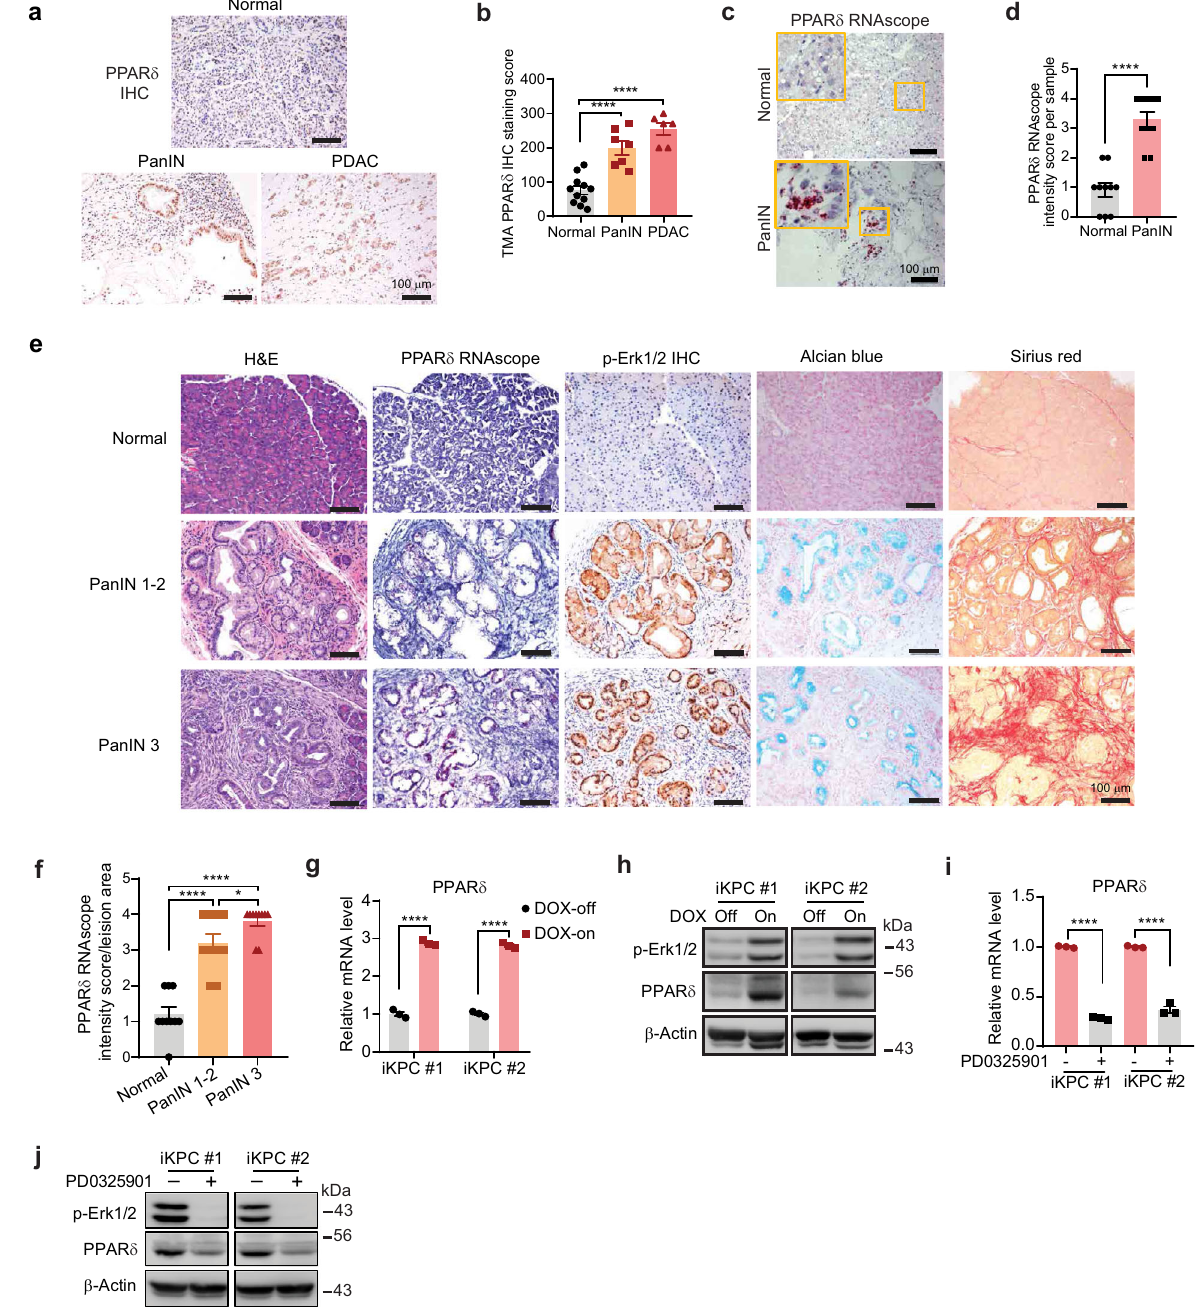
Fig. 1 PPAR δ expression is upregulated in human and mouse PanINs and regulated by KRAS mu activity. a , b PPAR δ protein expression in human normal, PanIN 1-2, and PDAC pancreatic tissues in a tissue microarray (TMA), measured by immunohistochemistry (IHC). a Representative images of PPAR δ IHC staining of the indicated groups of human pancreatic tissue samples. b PPAR δ IHC scores of normal ( n = 11), PanIN 1-2 ( n = 7), and PDAC ( n = 6) pancreatic tissues obtained from TMA. c , d PPAR δ mRNA expression levels in human normal and paired PanIN 1-2 ( n = 10), measured by RNAscope in situ hybridization. c Representative images of PPAR δ RNAscope in situ hybridization staining of the slides. Positive PPAR δ mRNA staining is shown in red dots. d Quantitative results of PPAR δ intensity scores. e Representative images of hematoxylin and eosin (H&E) staining, PPAR δ RNAscope in situ hybridization, phospho-Erk1/2 (p-Erk1/2) IHC staining, Alcian blue staining, and Sirius red staining of normal, PanIN 1-2, and PanIN 3 pancreatic tissues in KC mice. f Quantitative data of PPAR δ mRNA intensity scores of normal, PanIN 1-2, and PanIN 3 pancreatic tissues in KC mice as described in panel e ( n = 10 biologically independent samples). g , h Two independent iKPC cell lines were treated with 1 µ g/ml doxycycline (DOX-on) or control solvent (DOX-off) for 72 h, and then PPAR δ mRNA expression from three independent experiments was measured by qRT-PCR ( g ), and PPAR δ and p-Erk1/2 protein levels were measured by Western blot ( h ). i , j Two iKPC mouse PDAC cell lines cultured with 1 µ g/ml DOX were treated with 1 µ M MEK inhibitor PD0325901 for 24 h, and then PPAR δ mRNA expression from three independent experiments was measured by qRT-PCR ( i ), and PPAR δ and p-Erk1/2 protein levels were measured by Western blot ( j ). Data are mean ± SEM. For ( b , f ), one-way ANOVA with Bonferroni correction, and for ( d ), ( g , i ), unpaired two-tailed Student ’ s t -test. * P < .05 and **** P < .0001. Source data are provided in a Source Data fi